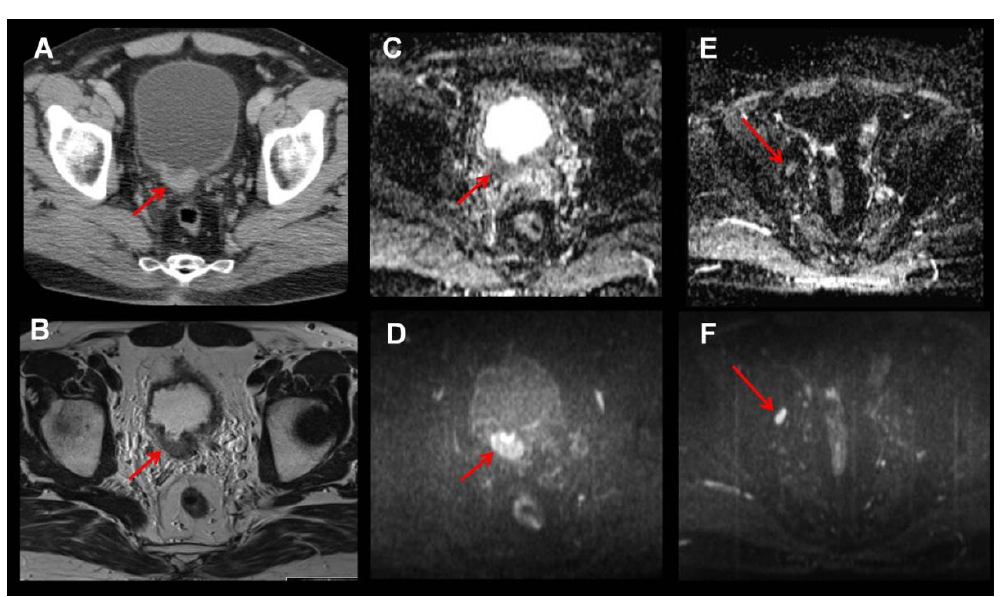
Figure 2. Bladder tumor at dorsal bladder wall visualized by CT as a wall thickening with contrast enhancement ( A ). Of note, soft tissue contrast is superior in MRI compared to CT ( B , T2w axial). Additional diffusion weighted imaging (DWI; C – F ) improves delineation of the tumor mass as a hyperintense mass in the b-value images ( D , b800 image) and allows evaluating apparent diffusion coefficient (ADC) values ( C ) as potential marker of tumor cellularity. Moreover, DWI might be helpful for evaluating lymph node metastasis, as metastatic lymph nodes usually also show lower ADC values ( F , b800 image showing a hyperintense iliacal lymph node on the right; E , low ADC value suggests